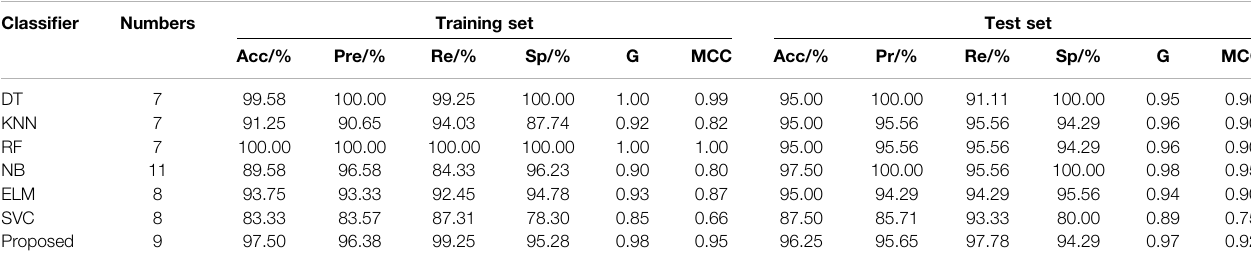
TABLE 7 | Comparison results of different classi fi ers. Classi fi